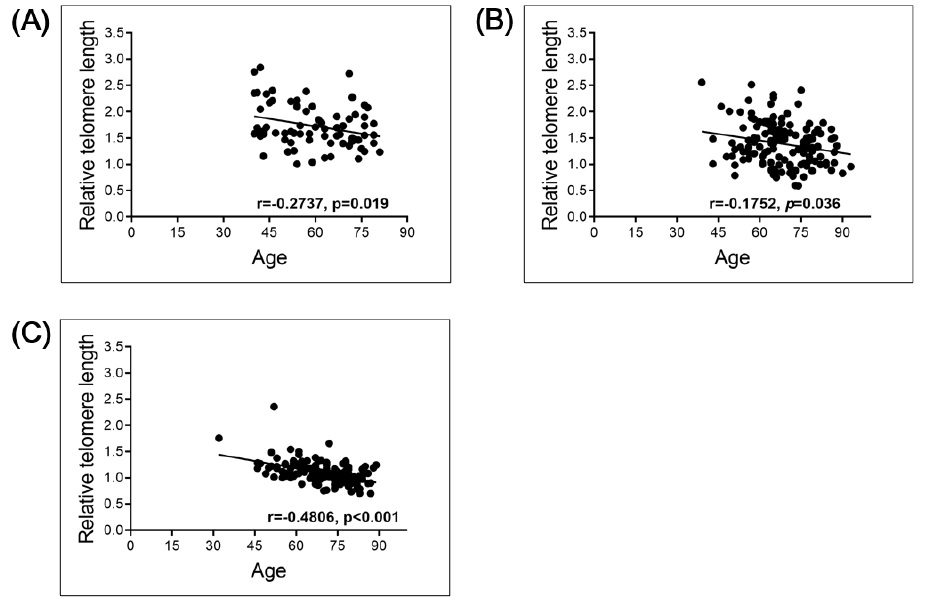
Figure 1. Linear correlation of RTL with age in normal control (NC), bladder cancer (BC), and renal cell carcinoma (RCC) groups: ( A ) NC group ( n = 73); ( B ) BC group ( n = 144); ( C ) RCC group ( n = 144).